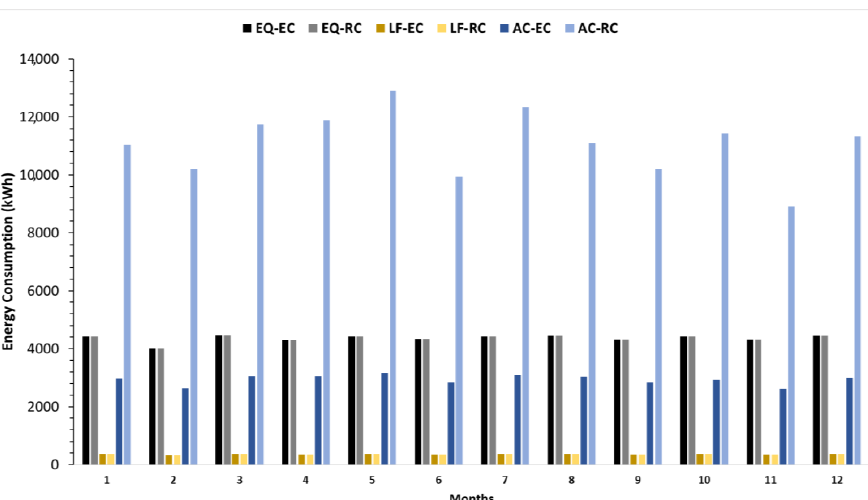
Figure 12. Comparison of electrical consumption by equipment (EQ), lighting (LF) and air condi- tioning (AC) in kWh between EC and RC.